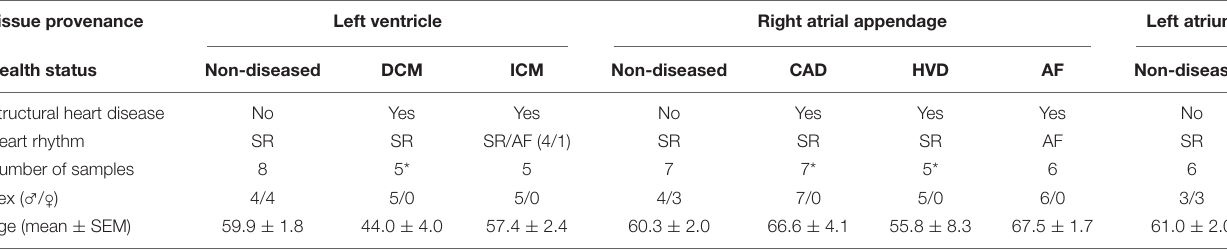
TABLE 1 | Patient characteristics of sequenced samples. Tissue provenance Left